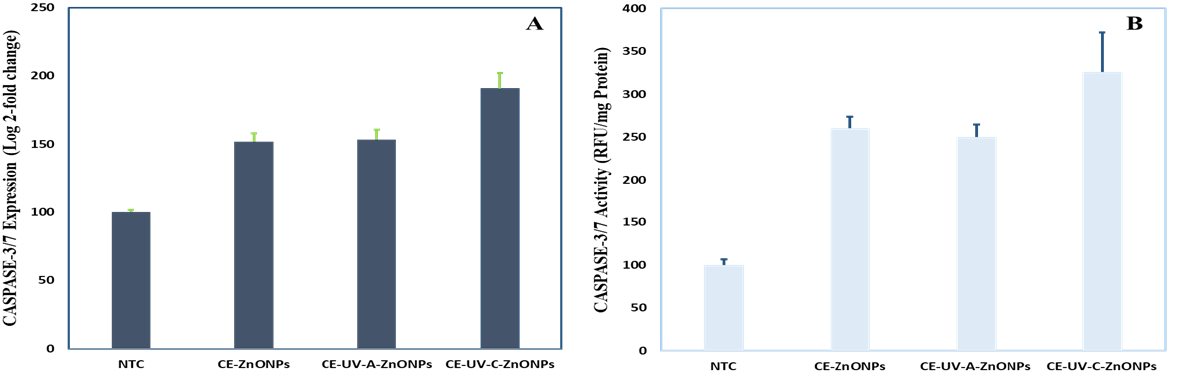
Figure 8. ( A ) Caspase3 gene expression ( B ) Caspase3/7 activity in response to ZnONP treatment of HepG2 cells.